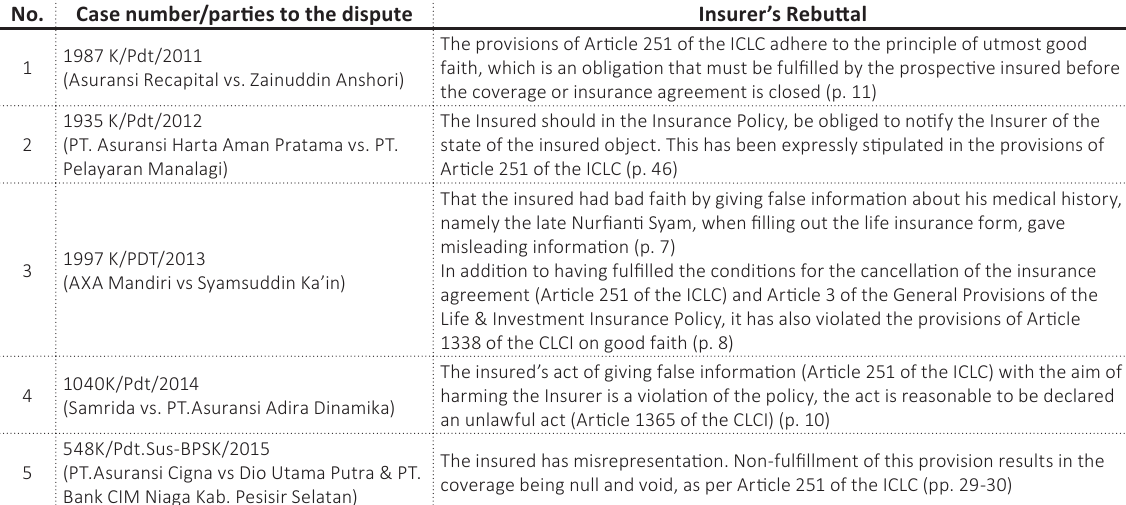
Table 2. Utmost good faith principle as a legal reason for insurers to harm the insured party Source: Processed from the Directory of Supreme Court Decisions,